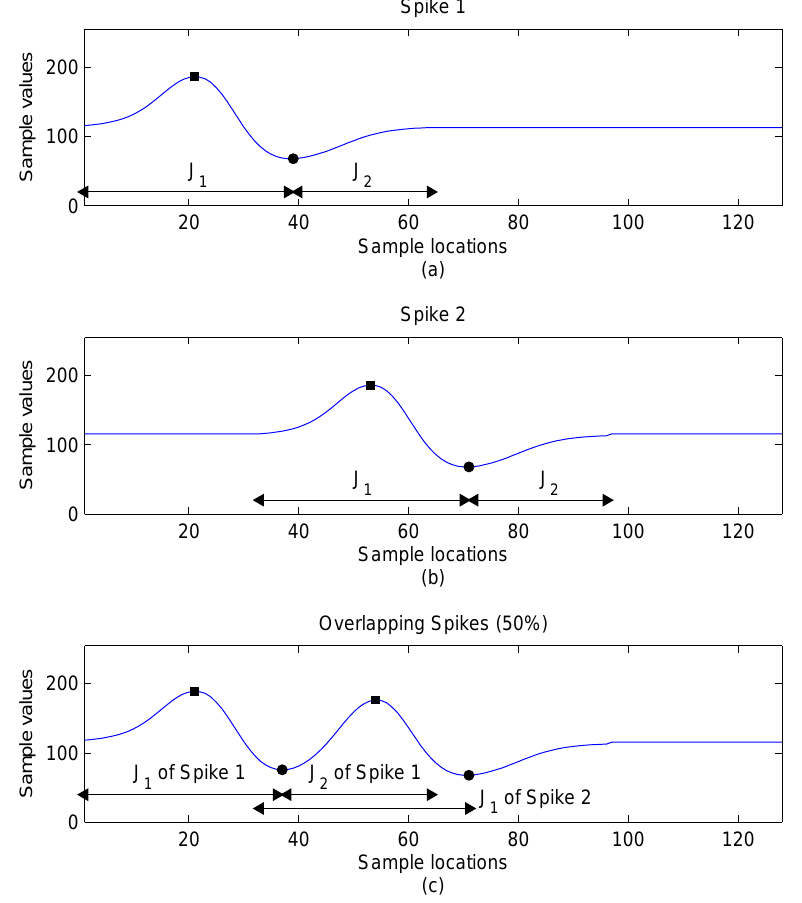
Figure 4. An example of two spikes overlapping by 50% for feature extraction. ( a ) Original Spike 1; ( b ) original Spike 2; ( c ) resulting waveform after the combination of the two